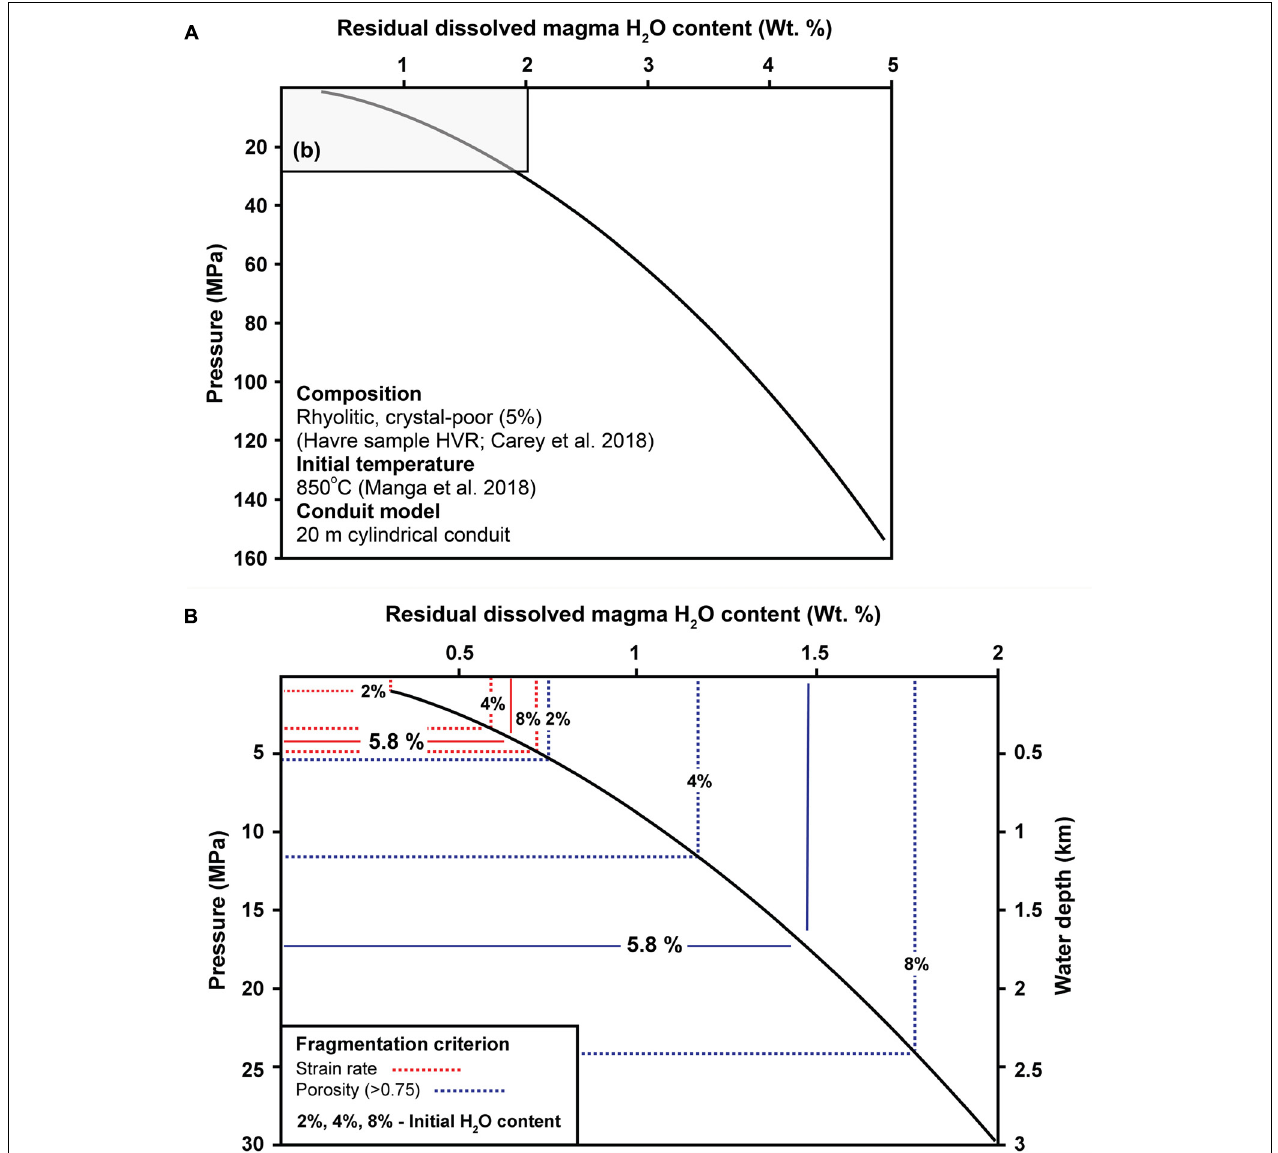
FIGURE 3 | (A) Modeled variation in residual dissolved magma H 2 O content in a crystal-poor, rhyolitic magma during magma decompression and ascent in a 20 m diameter cylindrical conduit, based on compositional data from Carey et al. (2018) and Manga et al. (2018) for samples from the 2012 submarine eruption of Havre volcano, Kermadec arc, southwest Pacific, using CONFORT 15 modeling program of Campagnola et al. (2016). (B) Enlargement of the field shown in the box in (A) . The solid and dotted blue lines show the residual magmatic water content left after the magma had vesiculated to ∼ 75 vol% for varying volatile contents. The solid blue line represents the initial 2012 Havre magma H 2 O content of 5.8 wt% (Manga et al., 2018). Red lines show the calculated depths and residual water contents coinciding with the conditions for the strain rate criterion that would cause explosive fragmentation. In each modeled simulation, a fraction of the available initial volatile content remains dissolved in the magma (top axis) at the point of fragmentation and the depth of fragmentation increases as a function of increasing initial volatile content. Note, strain rate driven fragmentation only occurs at depths of < 500 m, even if the initial magmatic water content was 8 wt.